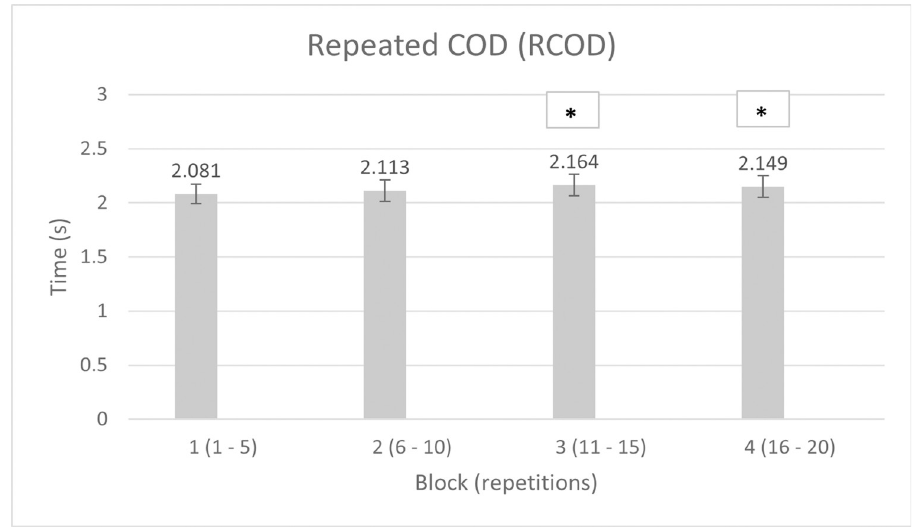
Fig 3. Mean times ± SD of RCOD blocks. � = different from block 1 (p < 0.05).